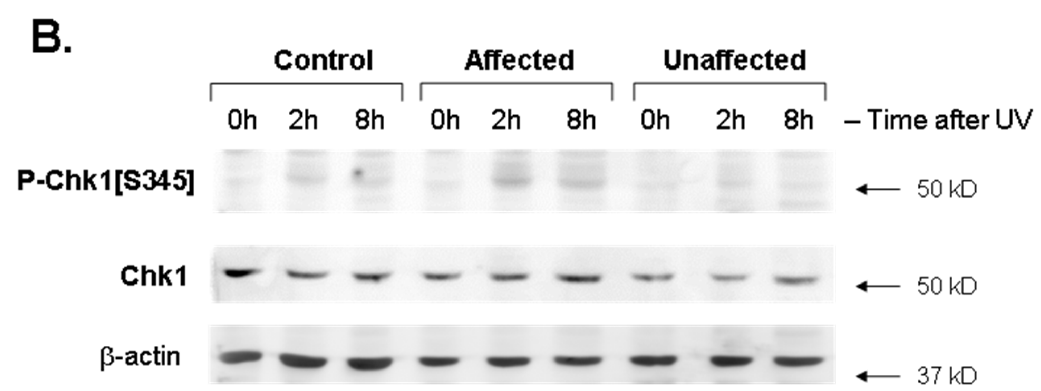
Figure 1. Phospho-Chk1[S345] induction by dFb from affected LFS compared to unaffected or control subjects in response to UV exposure. Protein extracts of cultured dFb were subjected to immunoblot analysis following UV irradiation, as described. ( A ) Chemifluorescent signals corresponding to phospho-Chk1[S345] (56 kD) were normalized to those of total Chk1 protein (56 kD) following UV irradiation for each dFb source ( n = 6: * p < 0.05, affected vs. unaffected dFb; † p < 0.05, affected vs. control dFb). ( B ) Results from representative immunoblot.